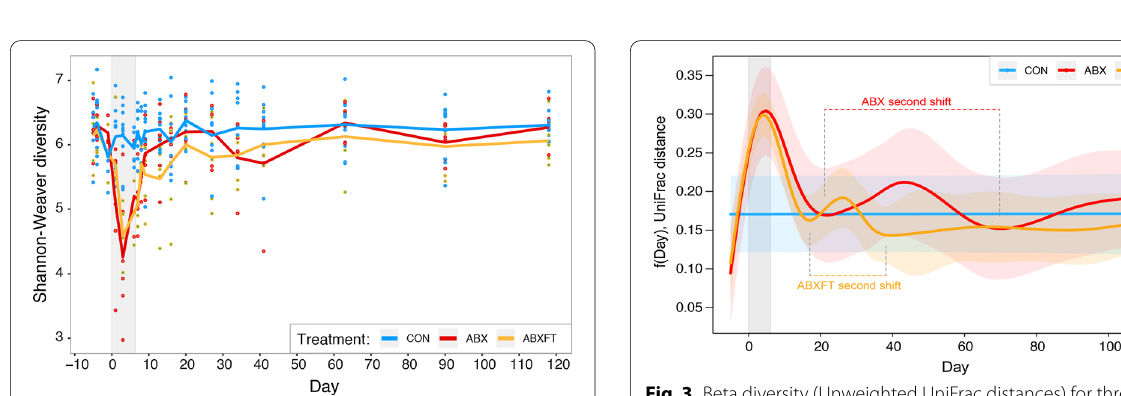
Fig. 3 Beta diversity (Unweighted UniFrac distances) for three experimental groups of male ring‑tailed lemurs ( Lemur catta ), represented as model‑predicted distances from baseline, with 95% confidence intervals. Shown are values for healthy animals that received no treatment (CON), antibiotics only (ABX), or antibiotics plus fecal transfaunation (ABXFT). Trajectories represent predicted responses with smoothing splines that reduce minor variation and noise (e.g., CON animals show minor variation over time in the raw beta diversity data (Figure S1), but the model‑predicted values are shown as a straight line). The gray shaded window represents the period of antibiotic treatment, with the prior period representing baseline and the subsequent period representing recovery. The second shifts away from baseline are identified and labelled for ABX and ABXFT